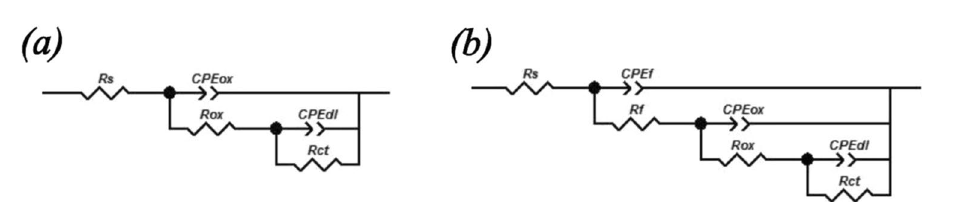
Figure 6. ( a ) Two-time and ( b ) three-time constants, used for fitting the impedance curves of the blank and Ce-DEDTC specimens,